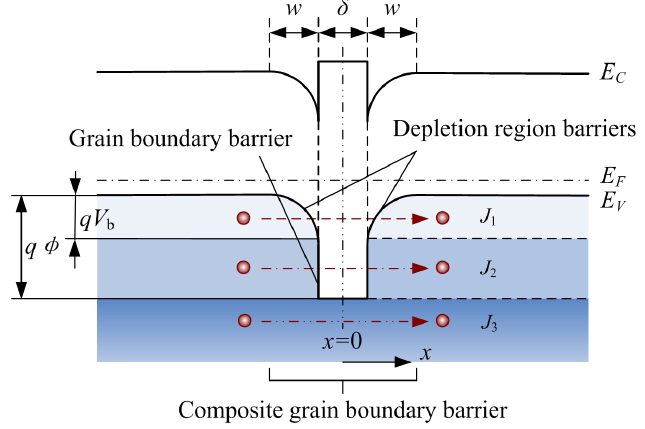
Figure 7. Energy band structure and carrier transport mechanisms near grain